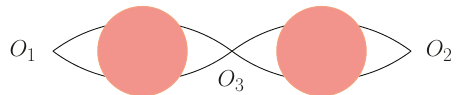
Figure 6. Cartoon of the extremal three-point function and its color